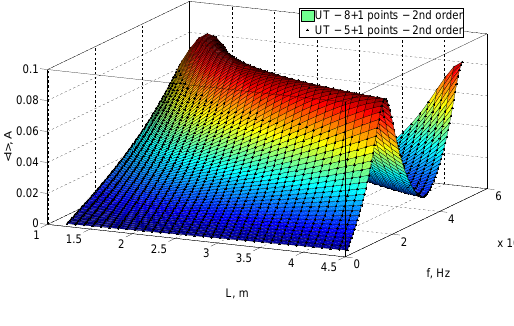
Figure 6: Mean( I ) from UT5 and